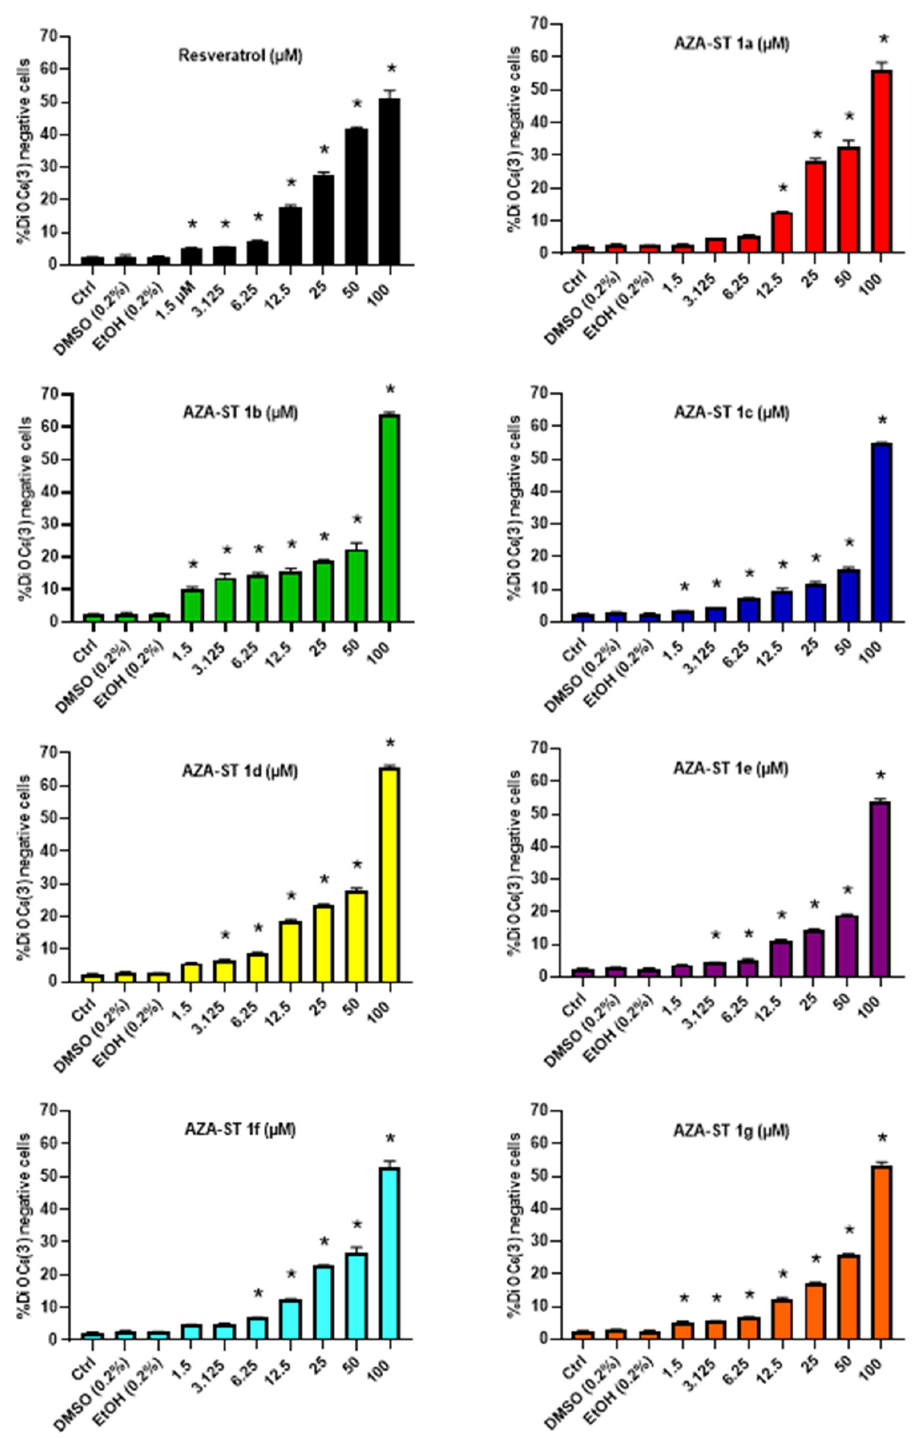
Figure 5. Flow cytometric evaluation of the effects of AZA-ST 1a–g and resveratrol on transmembrane mitochondrial potential ( ΔΨ m) by staining with DiOC 6 (3). N2a cells were incubated for 24 h with or without AZA-ST 1a–g or resveratrol (RSV; trans -resveratrol) at concentrations inclosing the IC50s (6.25, 12.5 and 25 µM). Vehicles (Ethanol (EtOH) for RSV; DMSO for AZA-ST) [15]: EtOH (0.2%) and DMSO (0.2%); the highest concentrations of vehicles were only analyzed. The data are the mean ± standard deviation (SD) of three independent experiments performed in triplicate. The comparison of the data was performed with an ANOVA test followed by a Bonferroni test. (*): p ≤ 0.05 was considered statistically